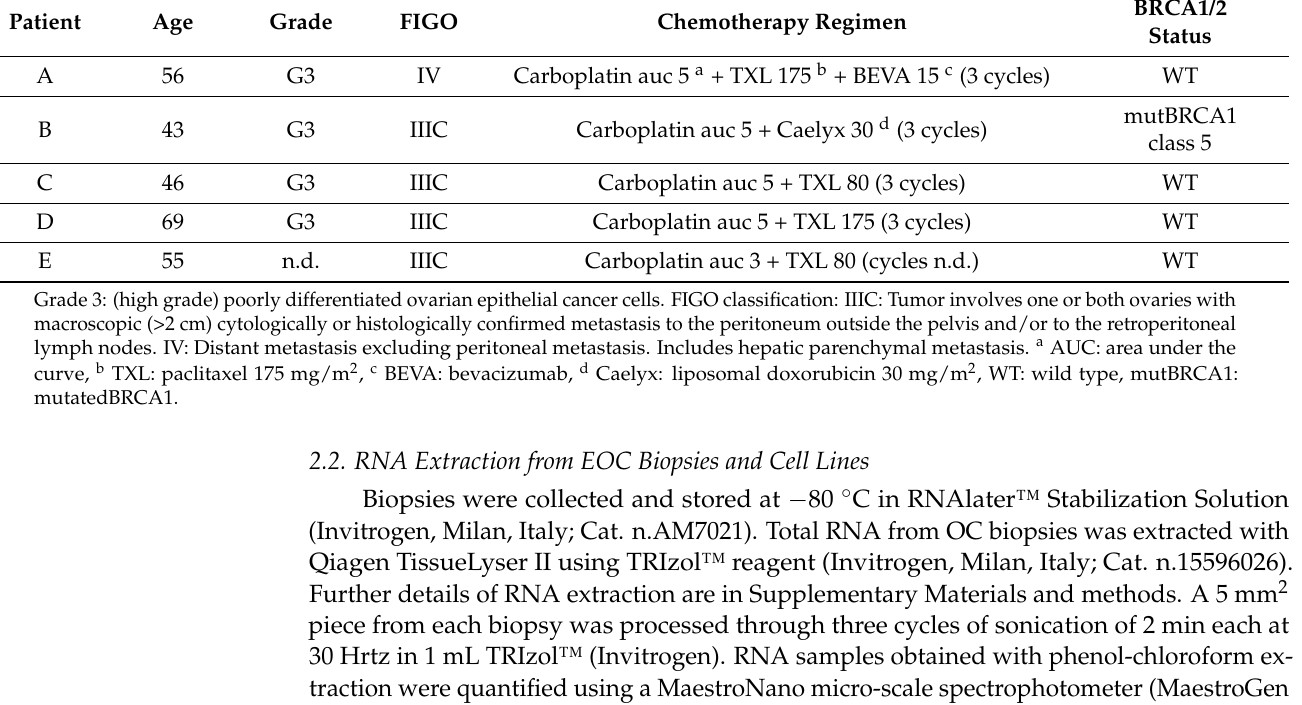
Table 1. Overview of HGSOC patients. International Federation of Gynecology and Obstetrics (FIGO) classification. Patient Age Grade FIGO Chemotherapy Regimen